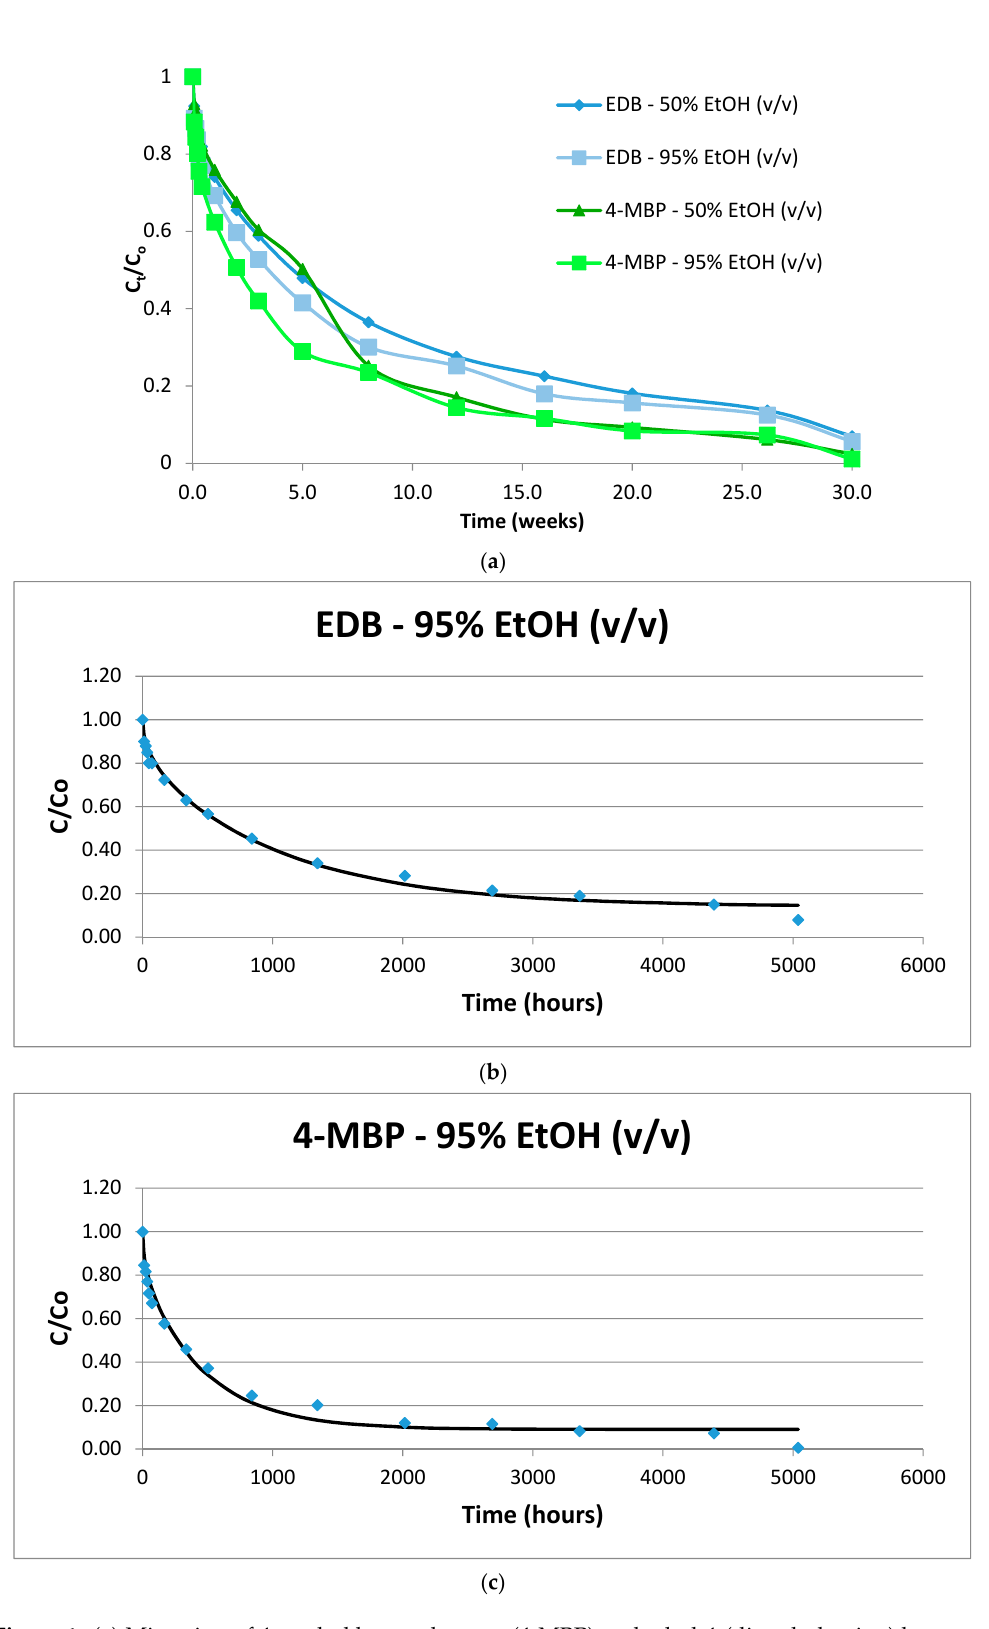
Figure 1. ( a ) Migration of 4-methyl benzophenone (4-MBP) and ethyl-4-(dimethylamino) benzoate (EDB) at − 18 ◦ C. C o : Initial concentration; C t : concentration at time t; ( b ) EDB 95% EtOH ( v / v ) ( − 18 ◦ C); ( c ) 4-MBP 95% EtOH ( v / v ) ( − 18 ◦